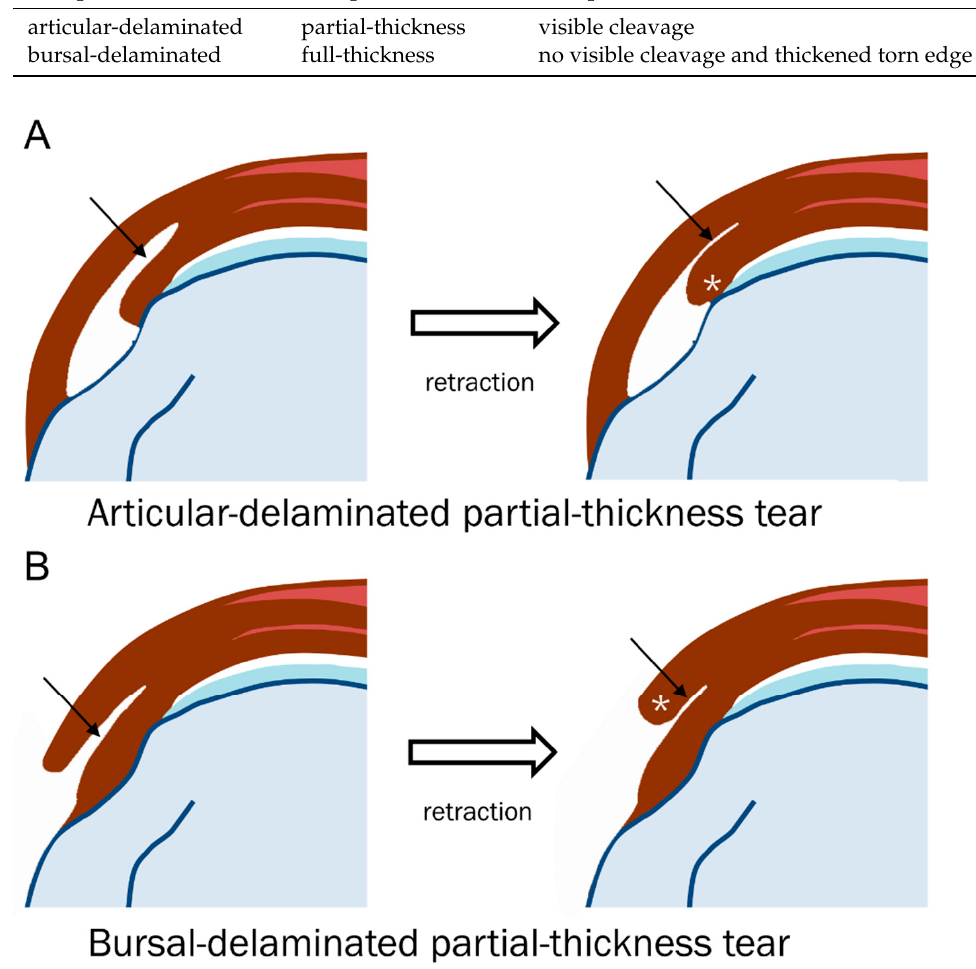
Figure 8. Schematic diagram of a delaminated tear with or without a visible cleavage. ( A ) At the initial, the articular-delaminated partial-thickness tear shows visible cleavage (arrow), and at retraction, it shows a retracted torn tendon (*) with uncovering cleavage (arrow). ( B ) At the initial, the bursal-delaminated partial-thickness tear shows visible cleavage, and at retraction, it shows a retracted torn tendon (*) with uncovering cleavage (arrow).